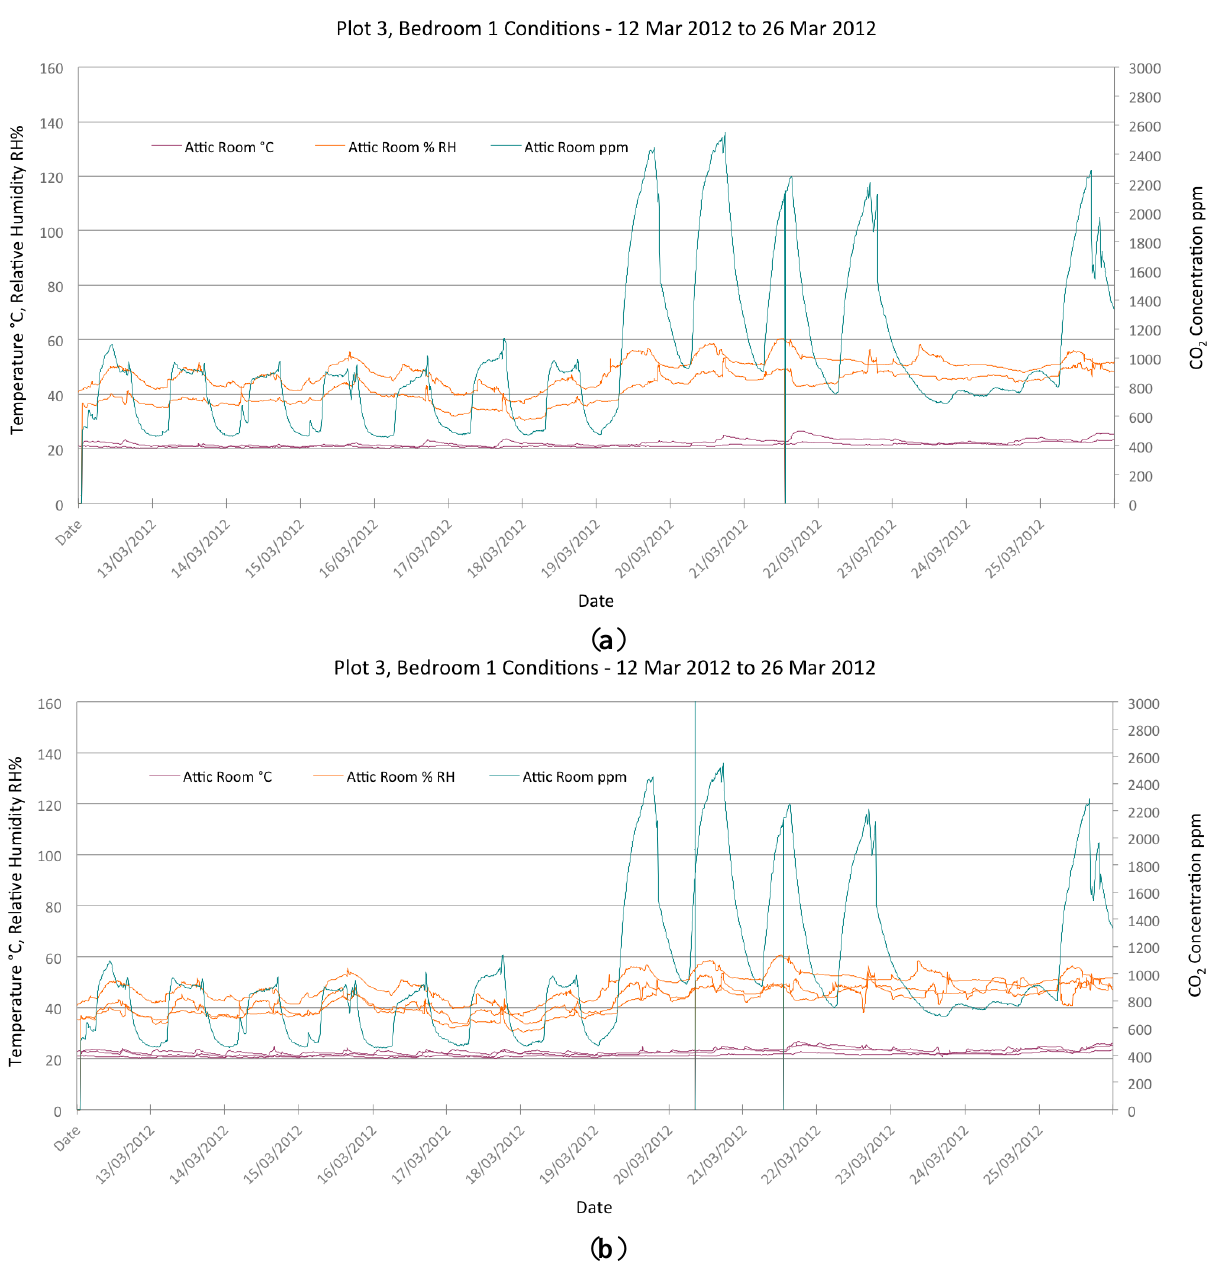
Figure 8. ( a ) CO 2 temp and levels SC2, Plot 1, Bedroom 4 (attic); ( b ) CO 2 temp and RH levels SC2, Plot 3, Bedroom 4 (attic).